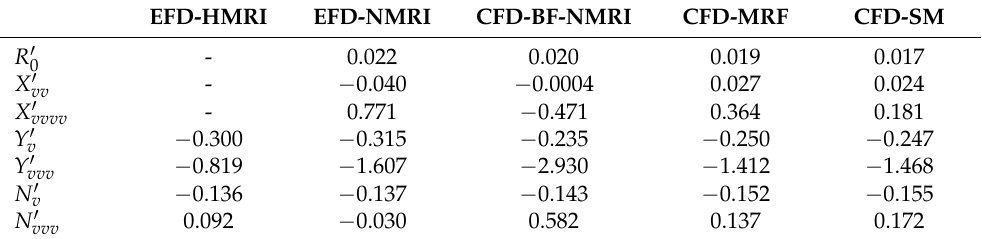
Figure 7. Results of linear regression analysis for hull-rudder interaction coefficients. Table 9. Resistance coefficient and hydrodynamic derivatives obtained from